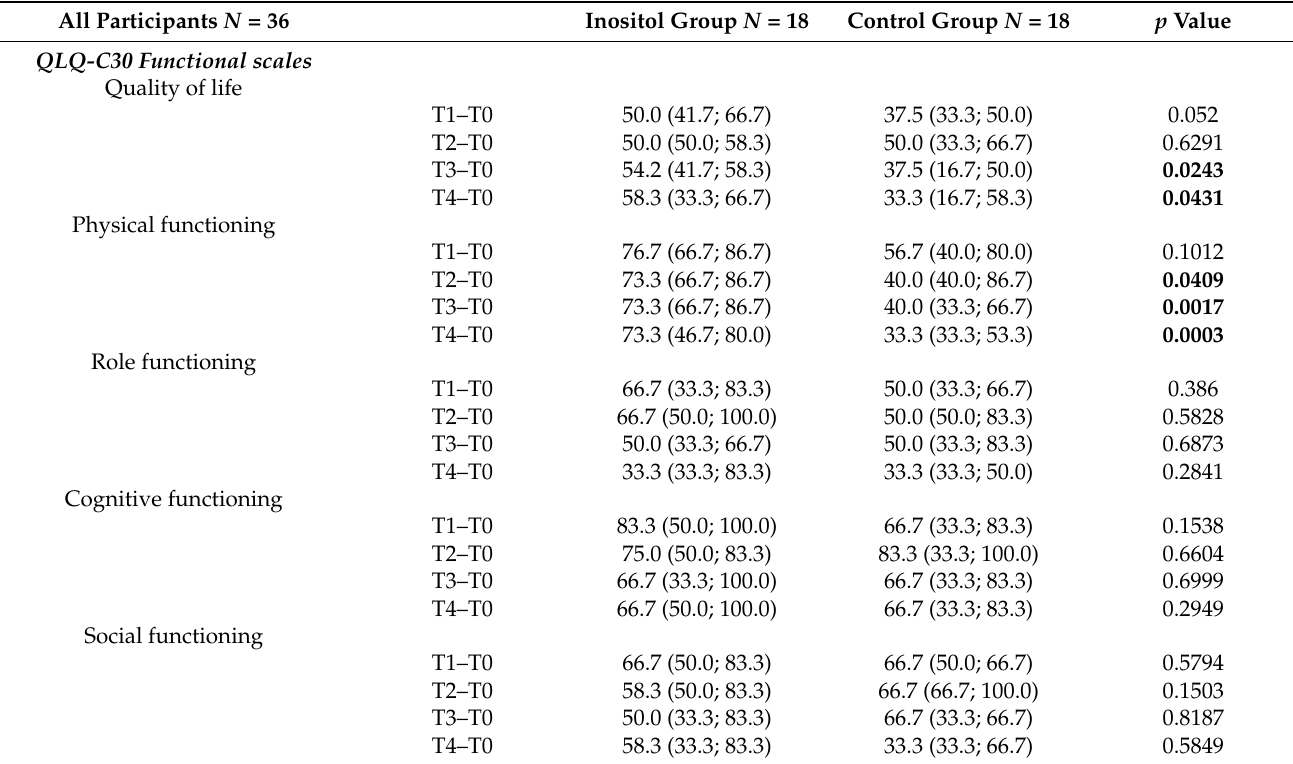
Table 5. Differences between the Inositol Group and the Control Group during the follow-up (T1-T4) in QLQ-C30 questionnaire